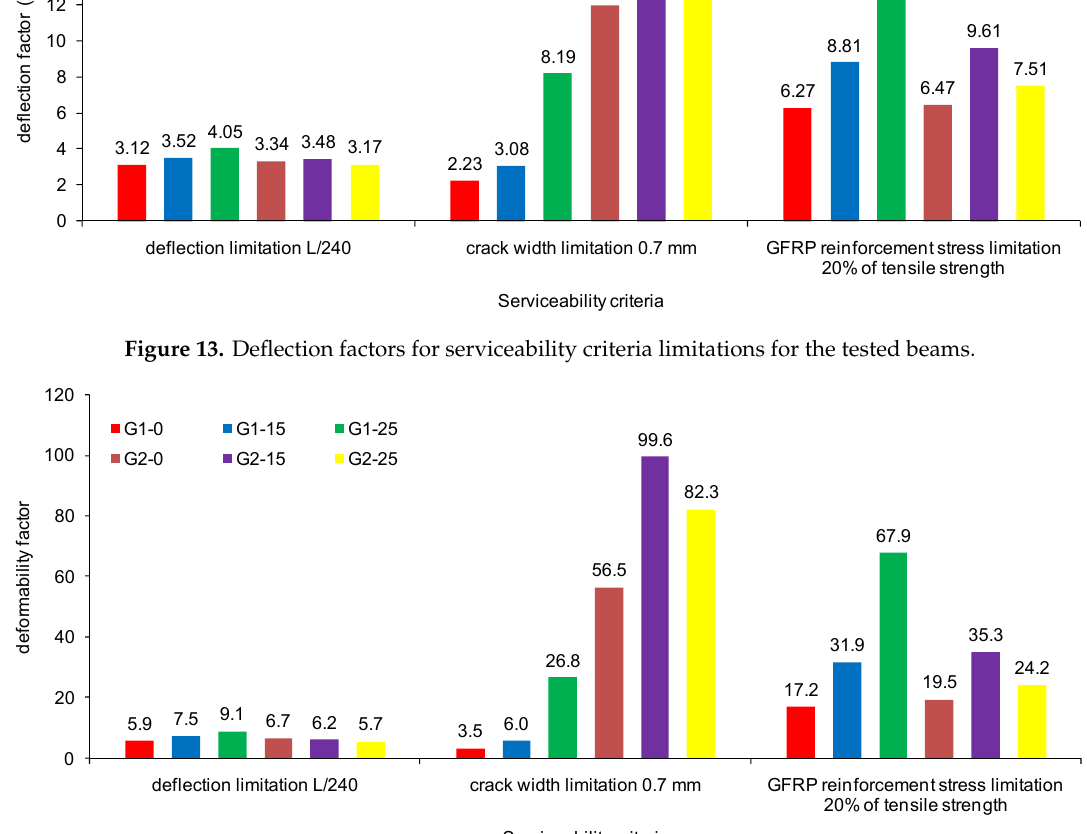
Figure 14. Deformability factors for serviceability criteria limitations for the tested beams.